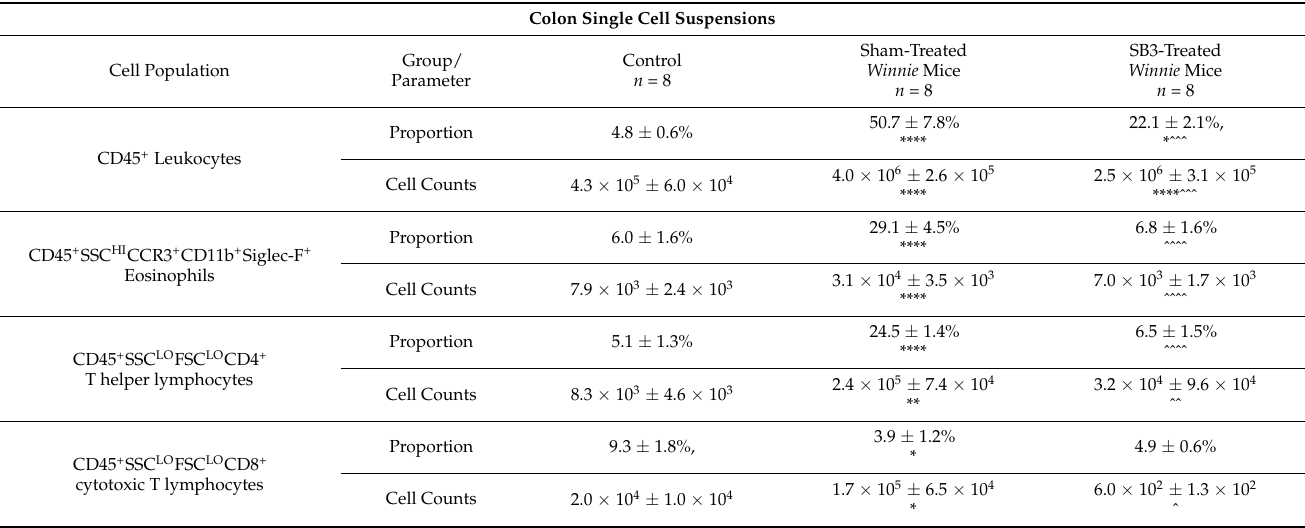
Table 2. Flow cytometry analysis discerning changes in the proportion and cell counts for leukocytes in the colon, spleen, blood, and bone